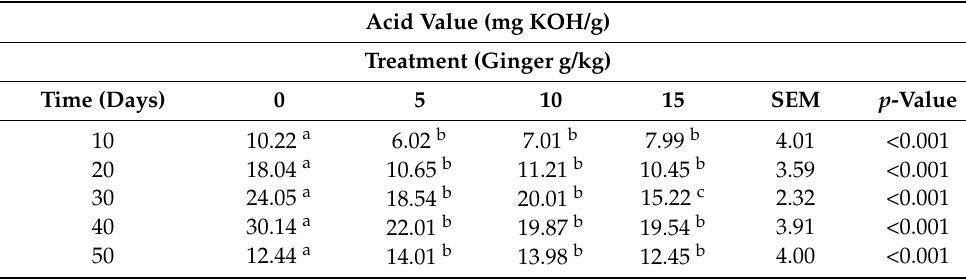
Table 6. Acid value (AV) of lipid extracted from stored ginger-supplemented dietary feed rations over the time of